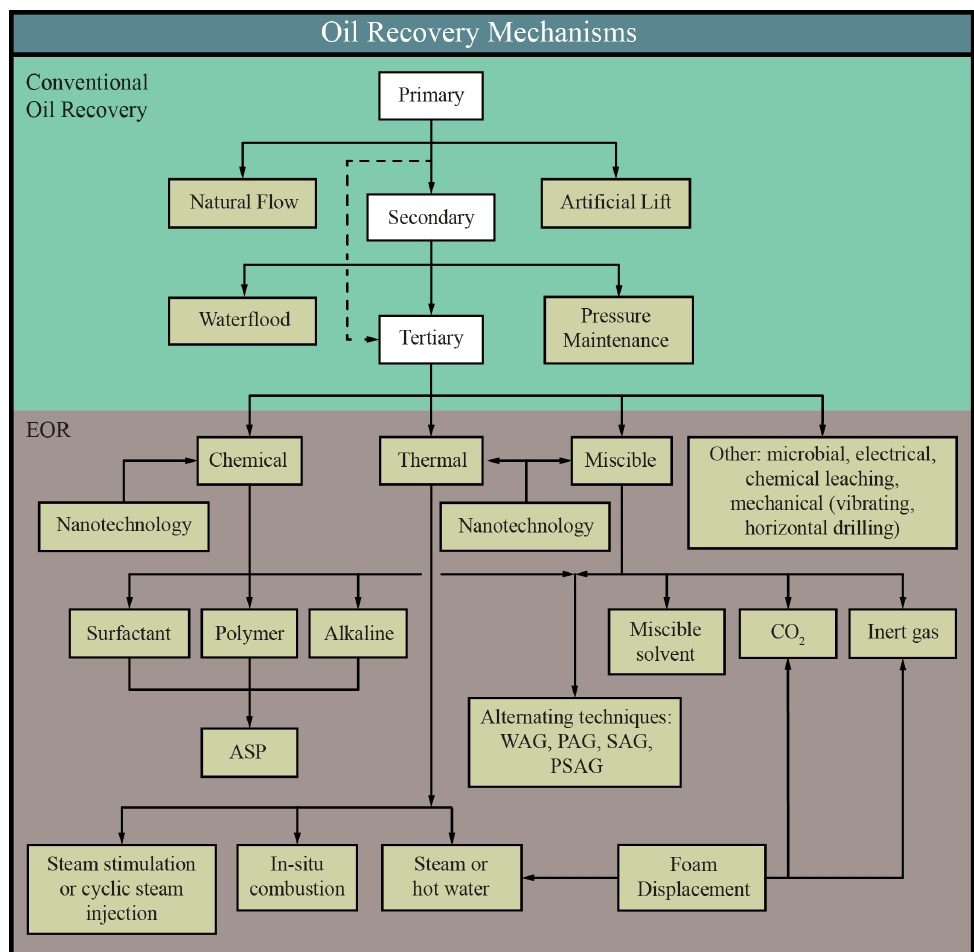
Figure 1. Scheme showing the oil recovery stages and the different techniques employed in EOR (reprinted/adapted with permission from